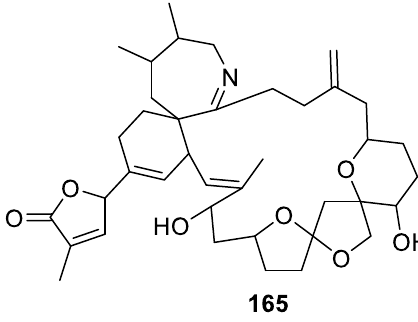
Figure 78. Spirolide G isolated from toxigenic dinoflagellate Alexandrium ostenfeldii .